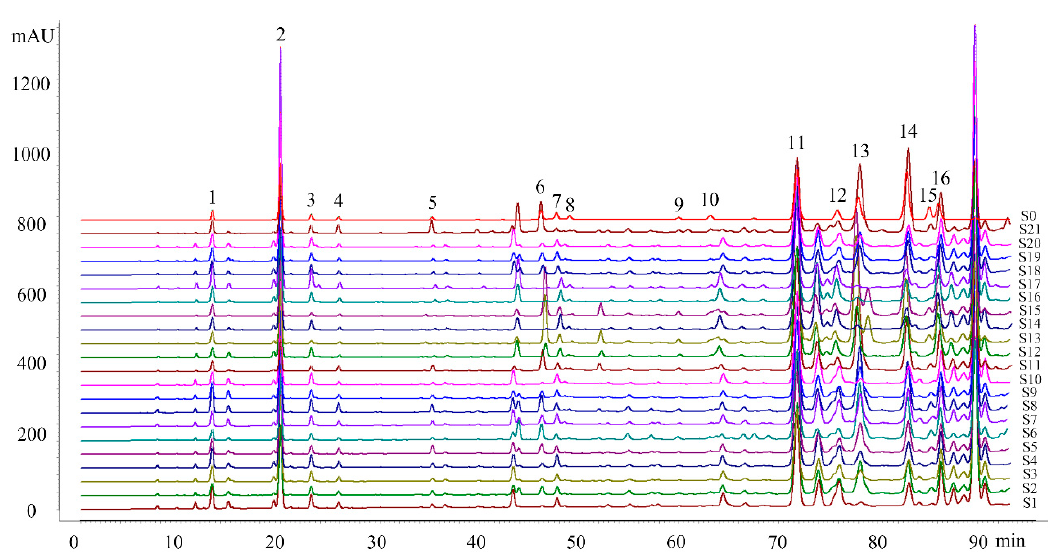
Figure 1. HPLC chromatograms of the CMB propolis (S1-S21) and standard solution (S0): 1. Caffeic acid;